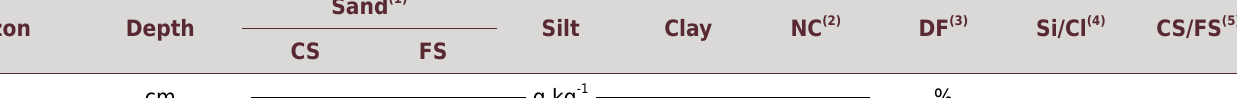
Table 3. Physical properties of soil profiles in a toposequence in Lavandeira, TO, Brazil Sand Horizon Depth